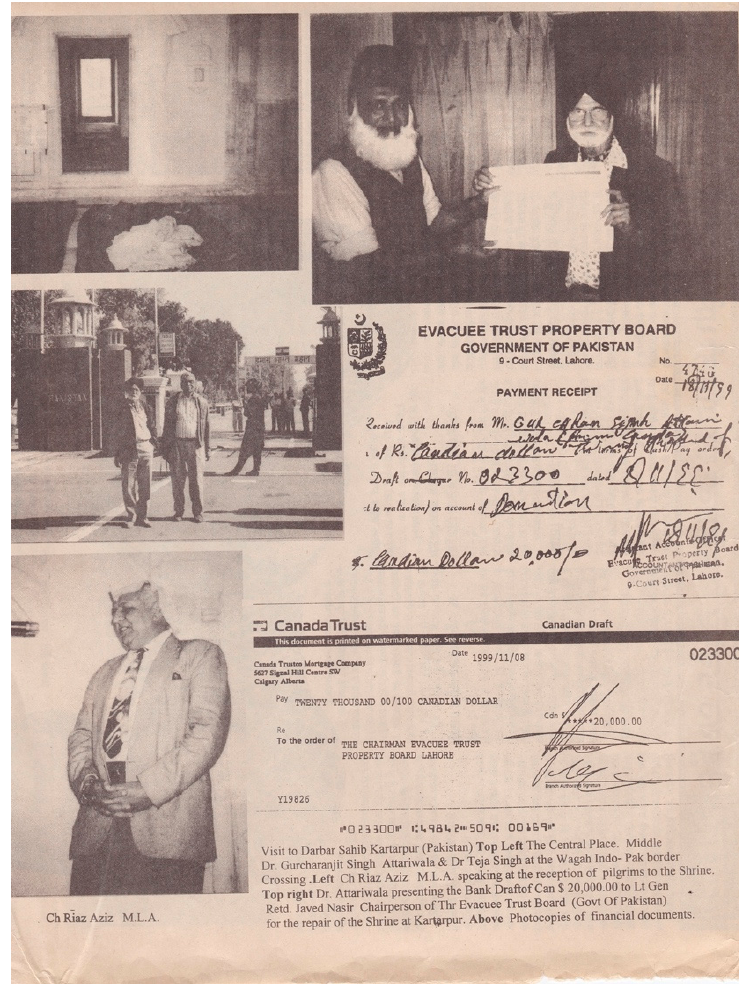
Figure 3. A January 2000 newspaper shared highlights from Dr. Attariwala’s visit to the November 1999 occasion. Top left: A picture taken by Dr. Attariwala during his initial visit in 1992 of the desolate interior in the abandoned Gurdwara. Middle left: Dr. Attariwala and Dr. Teja Singh crossing the Wagah border into Pakistan. Bottom left: Local member of parliament who attended the inaugural kirtan and addressed the sangat. Top right: Dr. Attariwala presenting a check to the minister in charge of shrines left by Indians in Pakistan, General Naser. Bottom right: Receipt and check of $20,000 Canadian dollars raised by the Guru Nanak Shrine